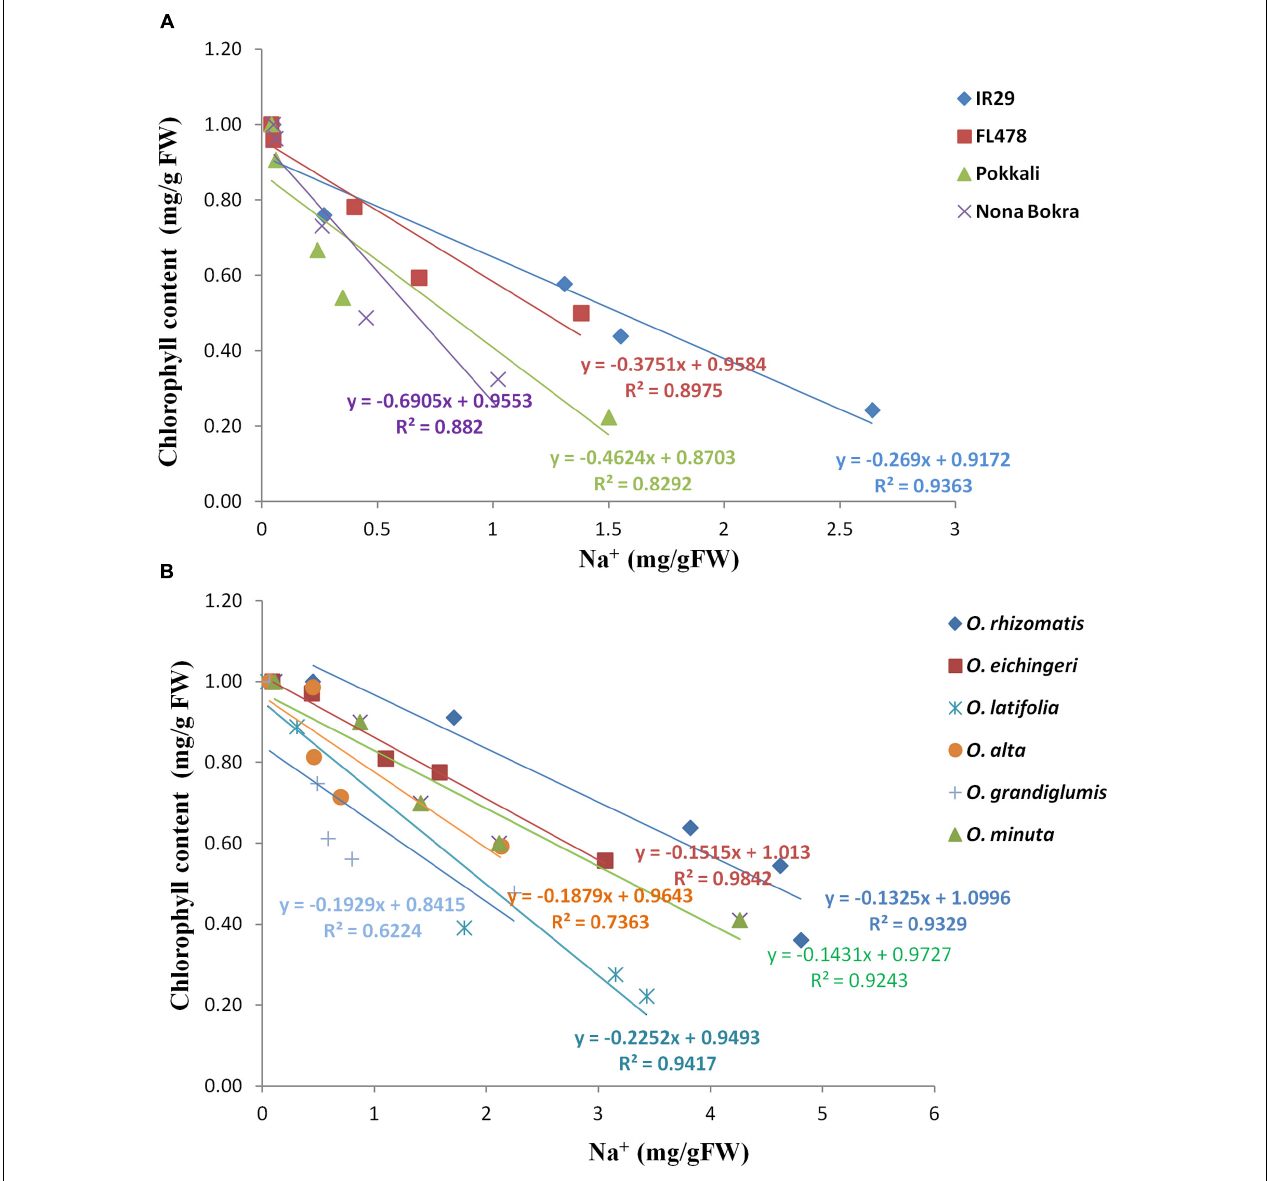
FIGURE 6 | Tissue tolerance score of tolerant wild species and cultivated checks as determined from the LC 50 value. Check lines (A) and wild salt-tolerant lines (B)